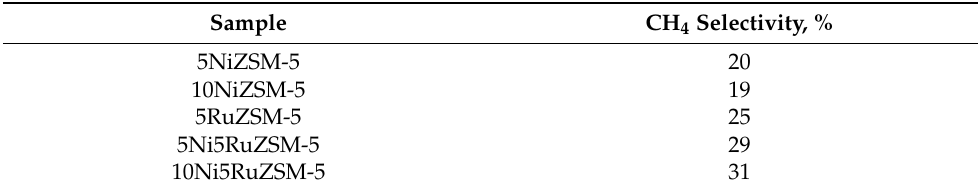
Table 4. CH 4 selectivity of the catalysts at similar catalytic activity